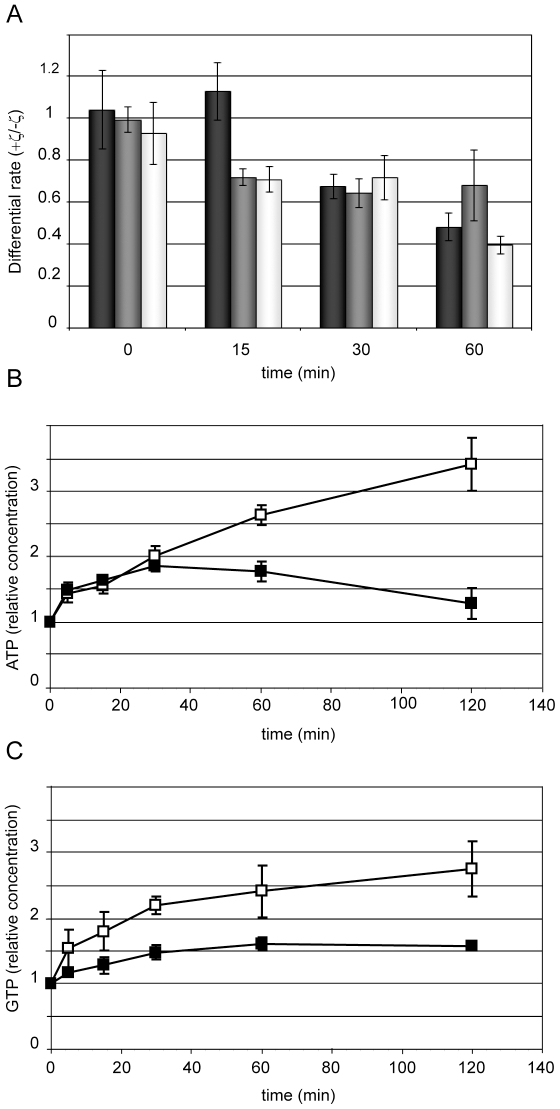
Effect of toxin expression on B. subtilis cell physiology.
xylR-P
XylAζY83C cells were grown in MMS7 medium. At time zero the culture was divided into two aliquots and Xyl (0.5%) was added to one sample to induce ζY83C expression. At various time points samples were taken and 2.5 µCi (6-3H)-thymidine (DNA synthesis, black bars), 2.5 µCi (5-3H)-uridine (RNA synthesis, dark grey bars) or 2.5 µCi L-(4,5-3H)-leucine (protein synthesis, white bars) was added. After a 1 min pulse of radioactivity incorporation, samples were chased for 2 min with an excess of unlabeled thymidine, uridine or methionine; cells were then lysed, the DNA, RNA or proteins precipitated and incorporated radioactivity measured in a scintillation counter (A). xylR-P
XylAζY83C cells were grown in MMS7 medium containing 50 µCi (32P)-KH2PO4. At time zero the culture was divided into two aliquots and Xyl (0.5%) was added to one sample to induce ζY83C expression (filled squares). At various time points samples were withdrawn, cells were then lysed, and the relative amount of ATP (B) or GTP (C) synthesized was measured. The ATP or GTP levels are arbitrarily defined as 1 at time zero.